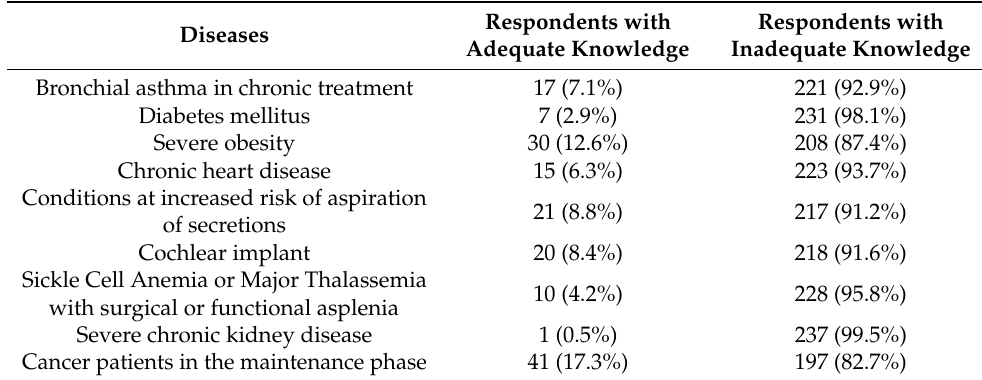
Table 3. Percentage of respondents with an adequate or inadequate knowledge about vaccination recommended in children with chronic